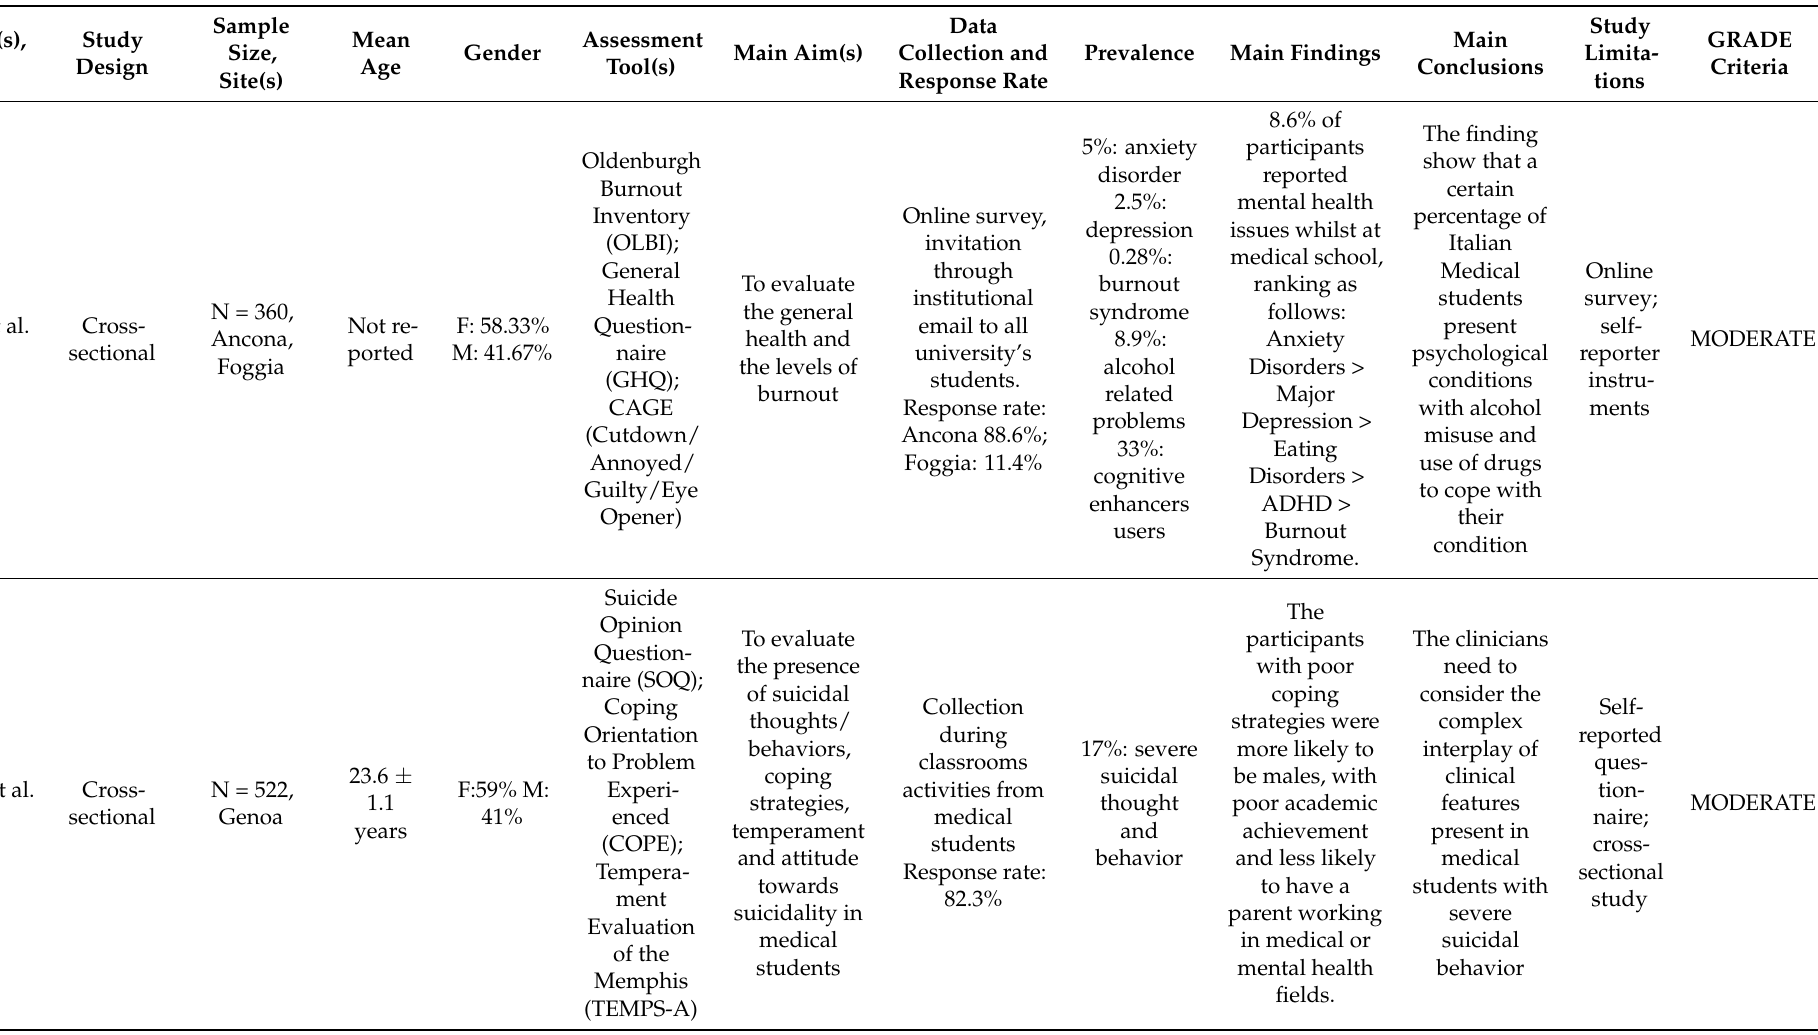
Table 2. Selected characteristics of the studies on health-related behaviours among Italian medical